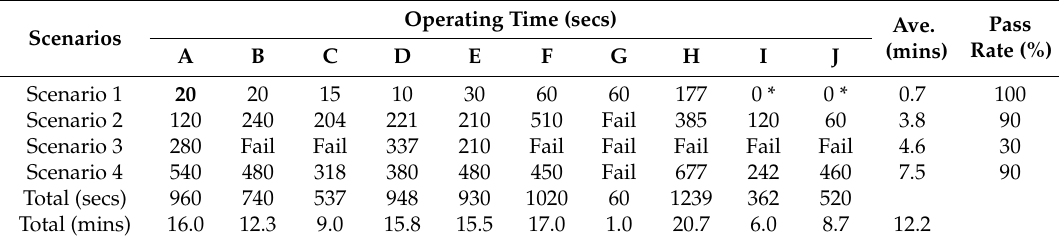
Table 4. The usability test results.